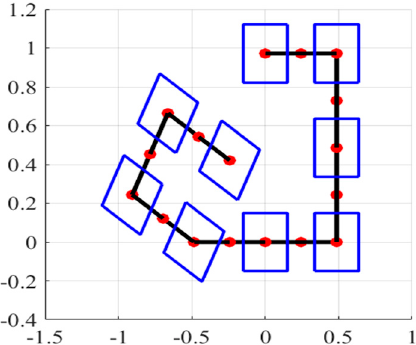
Figure 14. Initial configuration of SMSRS in case 1.